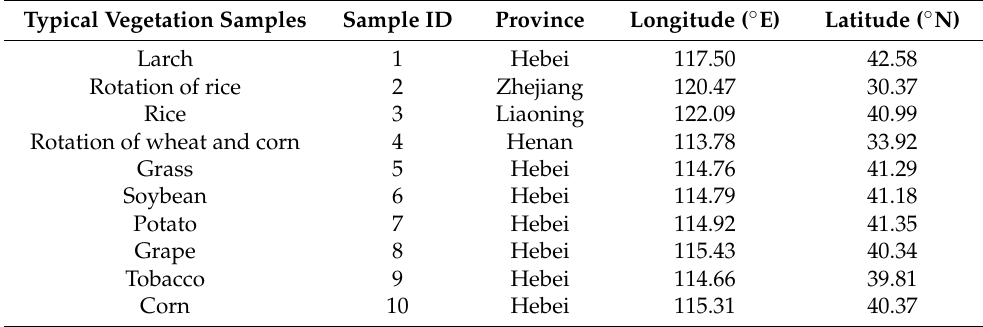
Table 1. Vegetation Species Samples